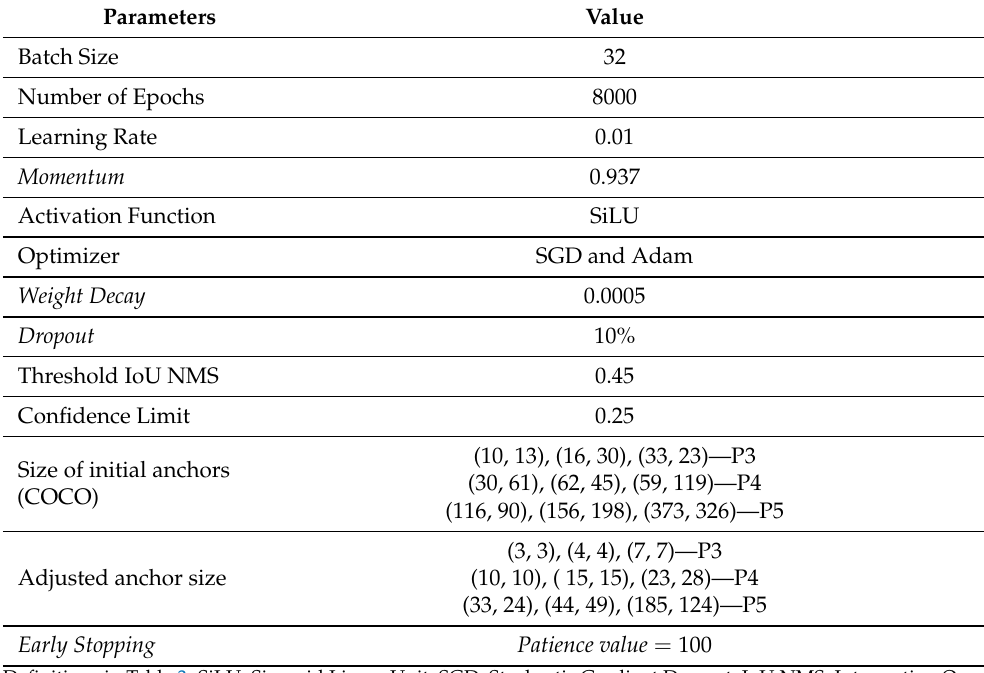
Table 3. Hyperparameters adjusted during the validation step using the Dataset for Diabetic Retinopa- thy